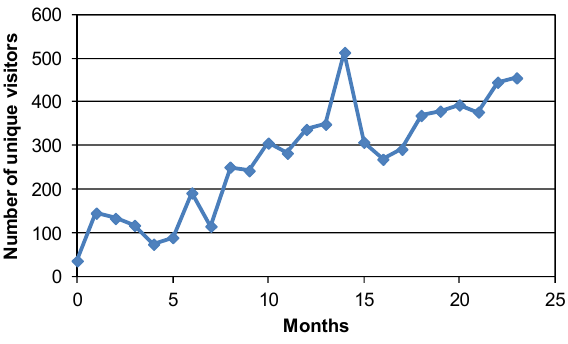
Fig.1: The number of unique monthly visitors at the JEB web site.